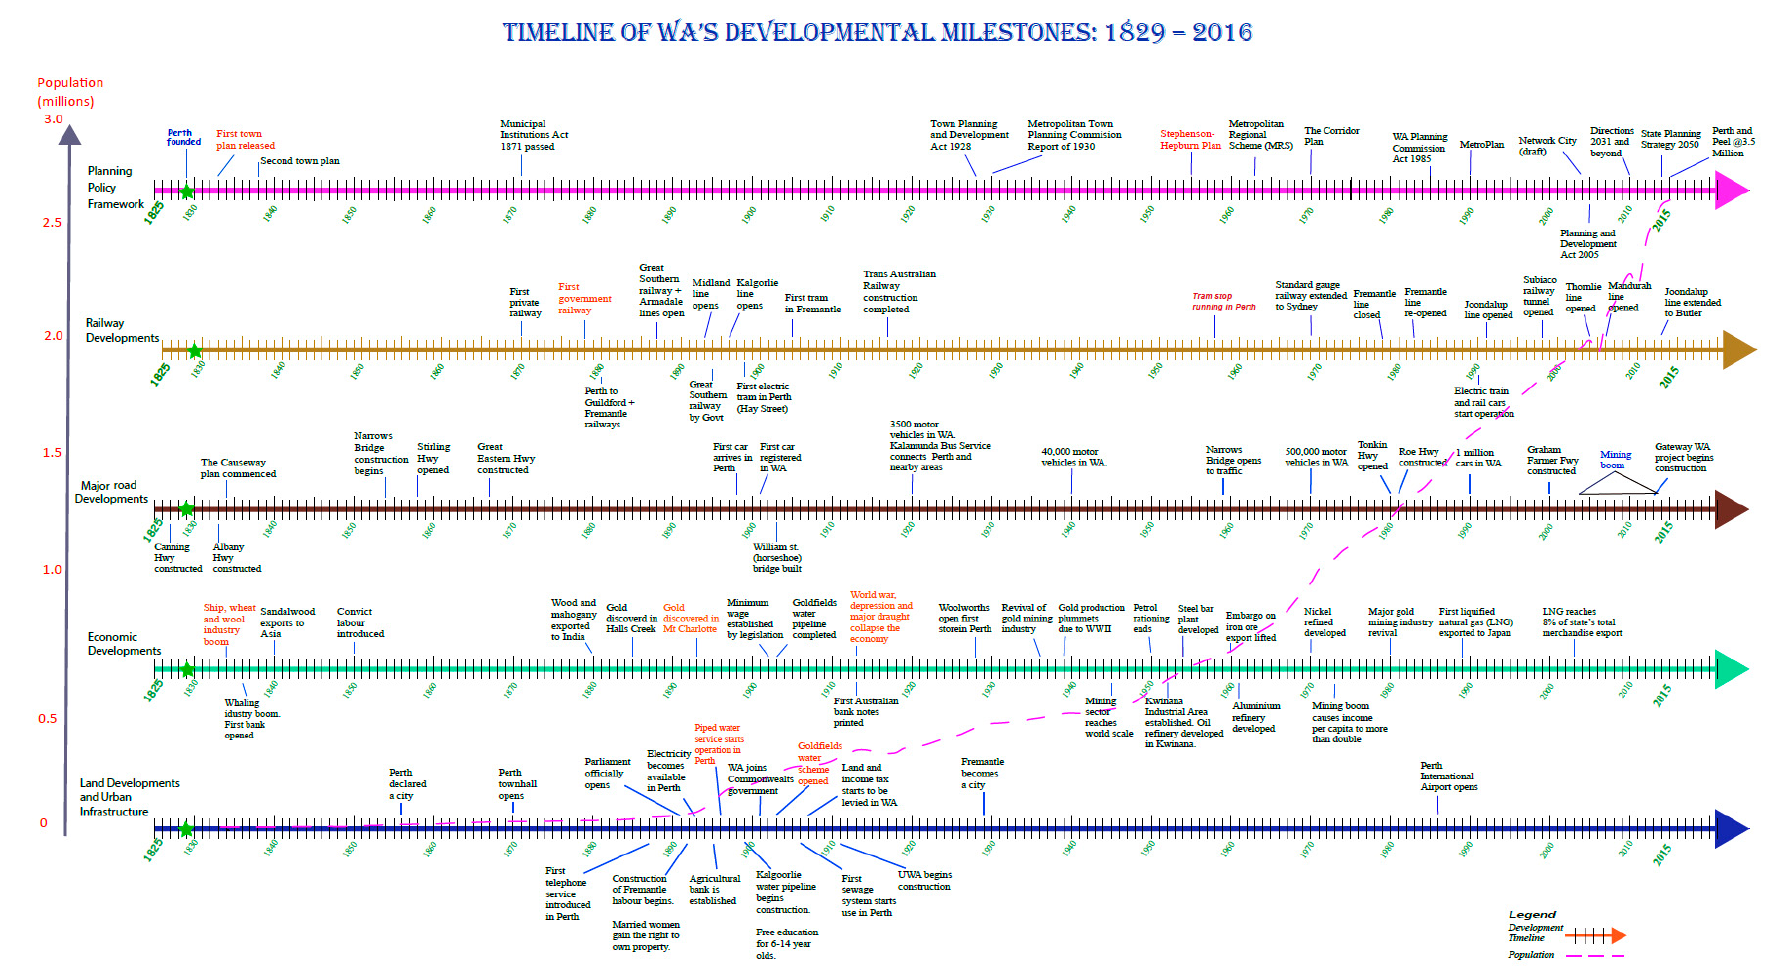
Figure 2. Timelines of major events/developments in the history of Perth. Source: Made by author. 33